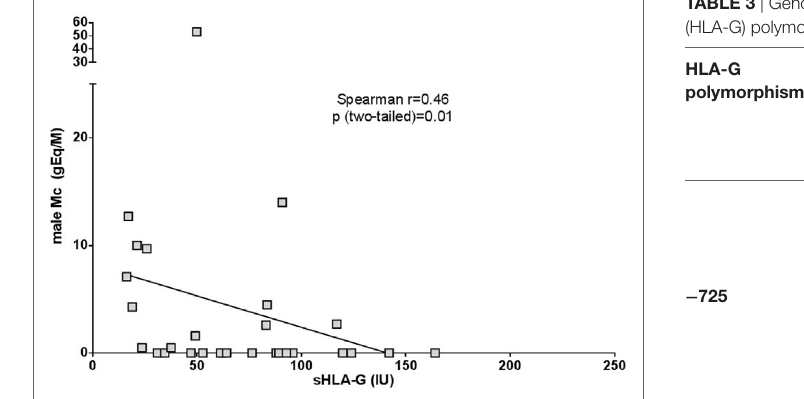
FigUre 4 | Correlation between male Mc quantities and soluble HLA-G (sHLA-G) levels in women with SSc. On the x -axis are represented values for sHLA-G expressed in International Units per mL of plasma (IU/mL). On the Y -axis are represented the genome equivalent of male microchimeric cells per million of mother’s cells (gEq/M). Correlation is assessed with Spearman rank correlation